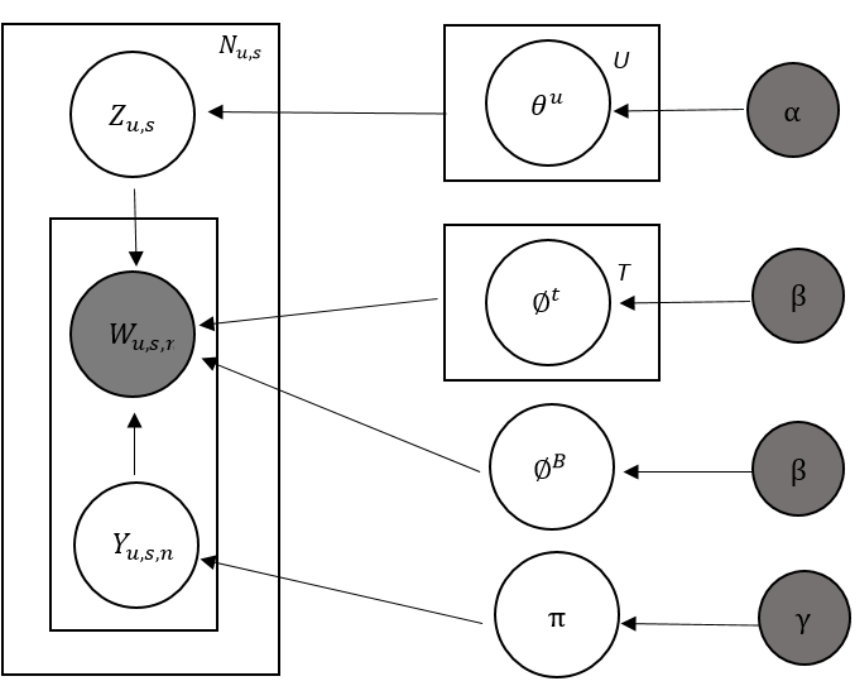
Figure 5. Plate notation of Microblogs Topic Discovery Model.